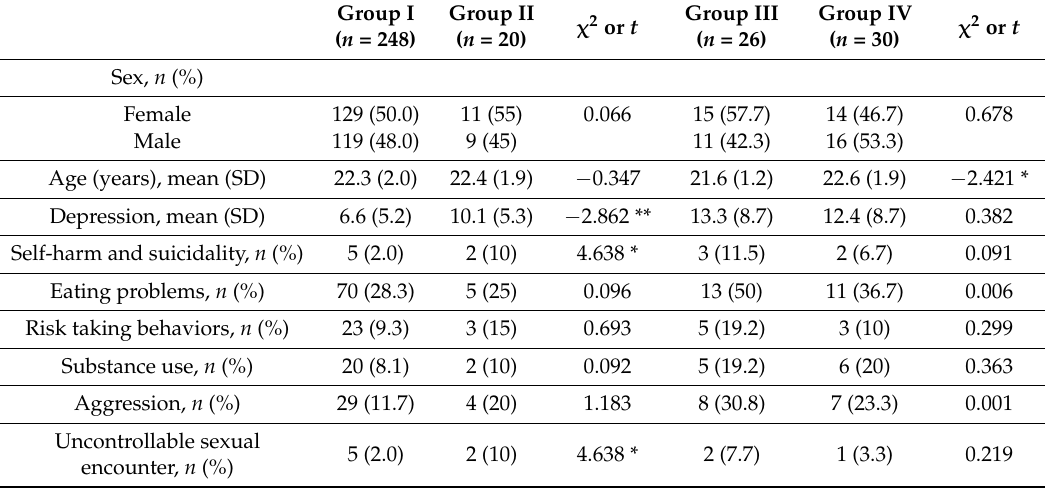
Table 1. Comparisons of demographic characteristics, depression, and problematic behaviors between groups I and II and groups III and IV.